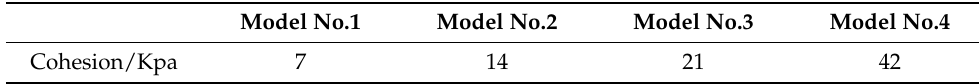
Table 10. Different cohesion value models.